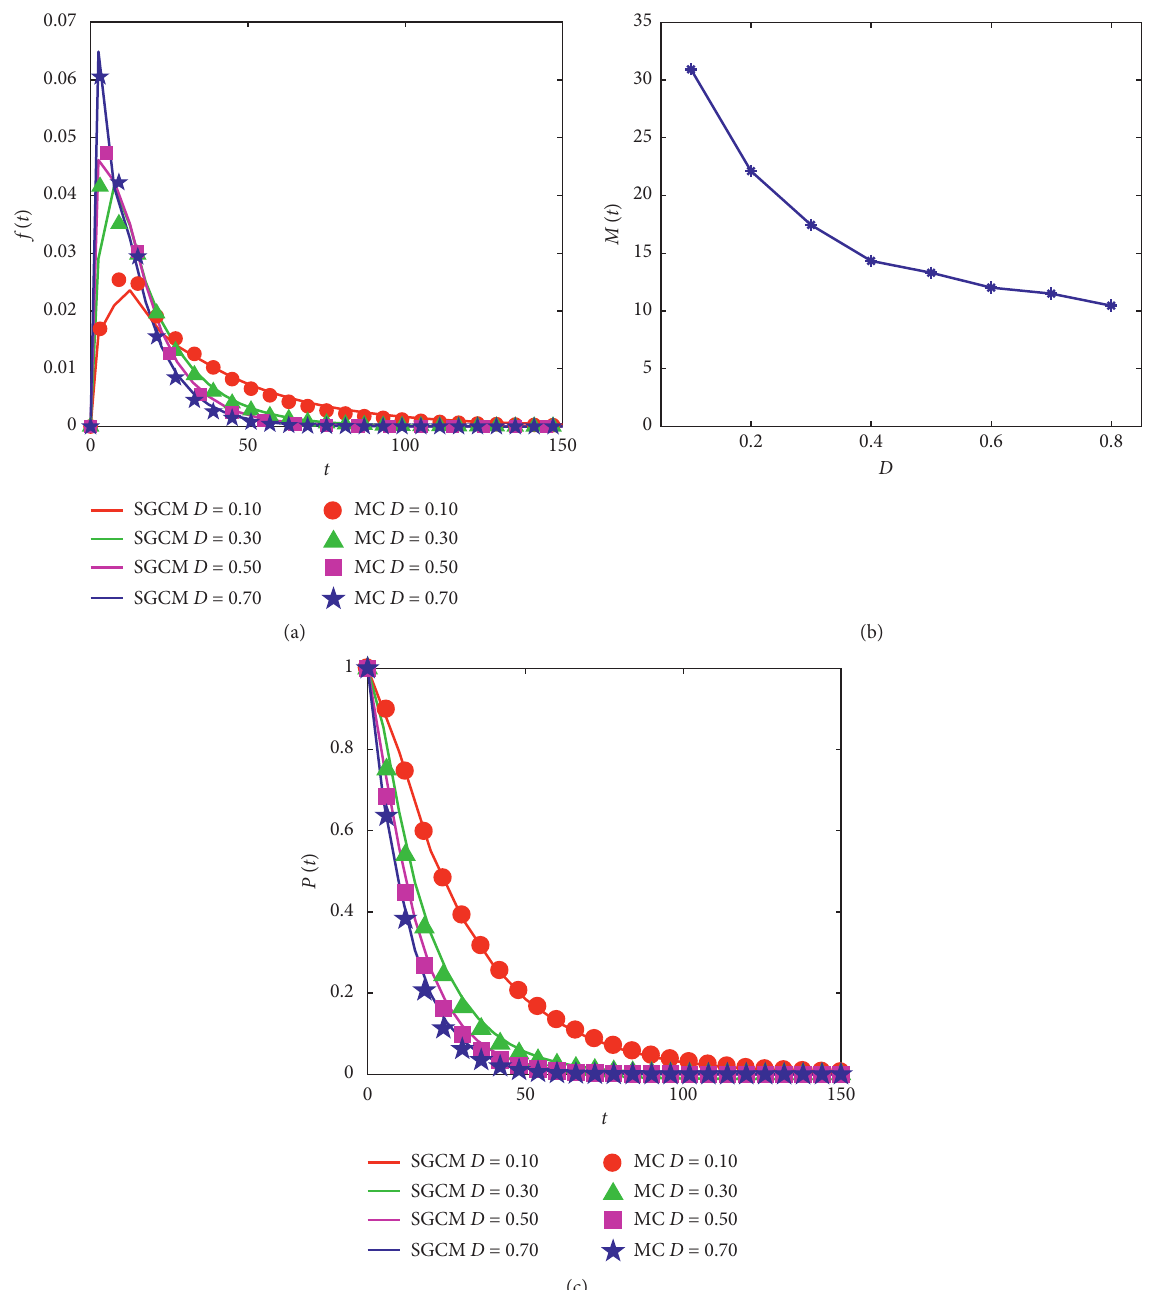
Figure 2: (a) PDF of FPT of system (6): λ � 0 . 30. (b). MFPT of system (6): λ � 0 . 30. (c) Reliability function of system (6): λ � 0 .